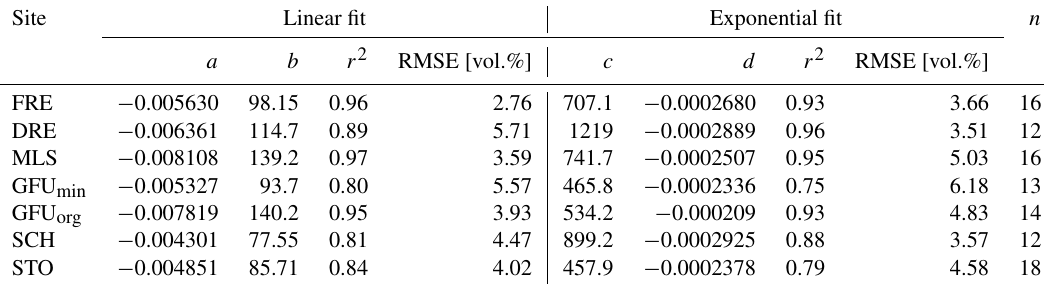
Table 4. Parameters and statistics of the linear and exponential calibration curve for each station. Site Linear fit Exponential fit n a b r 2 RMSE [vol.%] c d r 2 RMSE [vol.%] FRE −